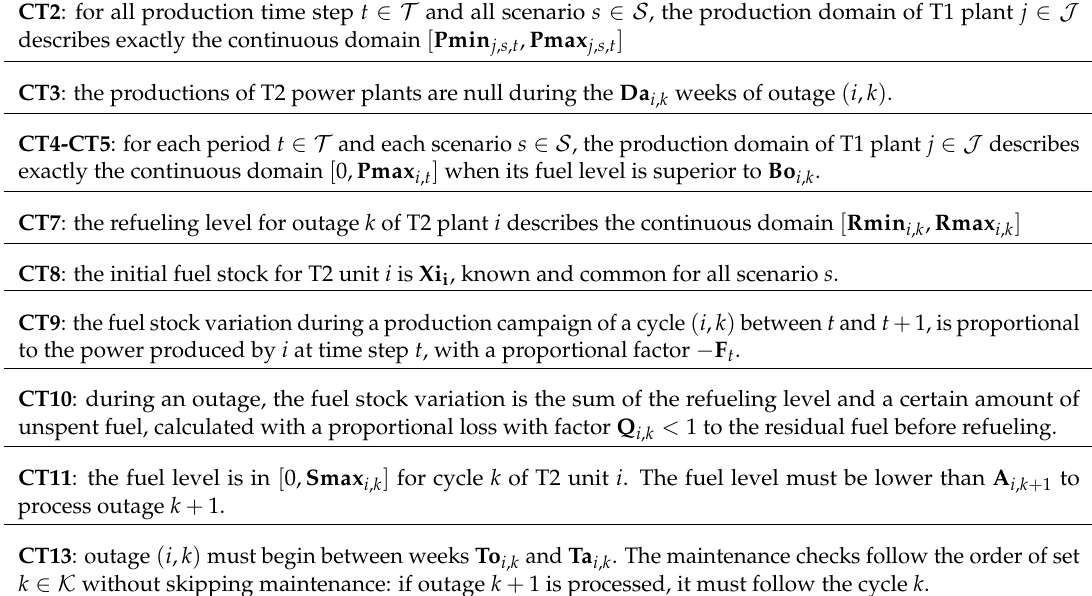
Table 3. Description of the constraints, with their references in the specification